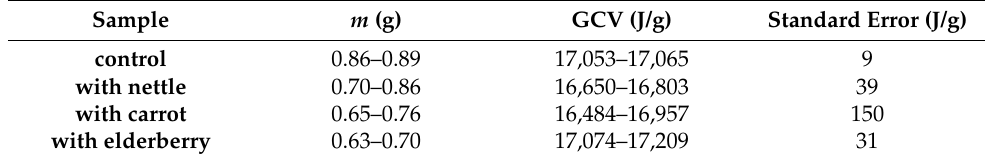
Table 5. Mass, gross calorific value, and standard error. GCV, gross calorific